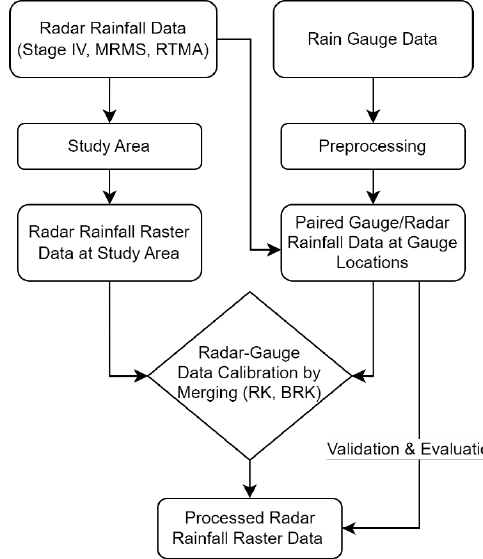
Figure 3. Flowchart of the methodology.